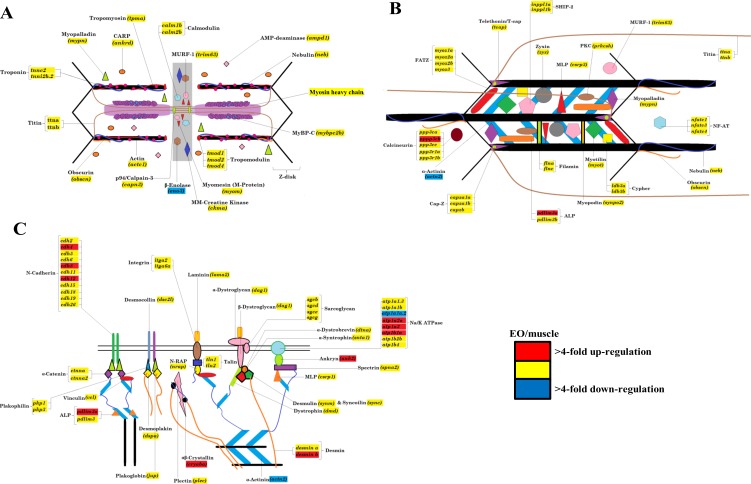
Model of the contractile apparatus and the relative expression levels of transcripts representing sarcomeric components in muscle and EO.(A) I-band, A-band, and M-line regions of the sarcomere; (B) sarcomere Z-disk region; and (C) cytoskeletal filament linkages at the sarcolemma of striated muscle. All sarcomeric genes correspond to those listed for mammalian sarcomeres in Ehler & Gautel (2008). Transcripts labeled in red, yellow and blue represent transcripts expressed at levels >4-fold higher in EO than muscle, similar in both EO and muscle, and <4-fold lower in EO than muscle, respectively. To date, we have not resolved the identity of all myosin heavy chain isoforms transcribed in muscle and EO of S. macrurus and thus, all identified isoforms have been included in one category, labeled “Myosin Heavy Chain” in this figure.